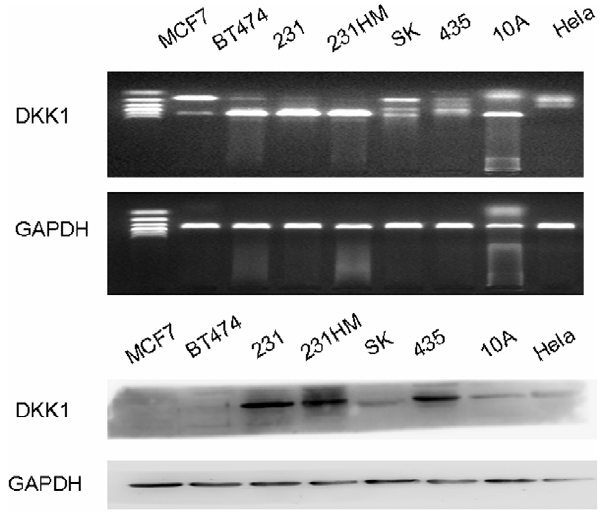
Figure 1. The mRNA and protein expression of DKK1 in breast cancer cell lines. A) The mRNA expression of DKK-1 in MCF-7, BT474, MDA-MB231, MDA-MB231HM, SK, MDA-MB-435, MCF-10A and Hela cells. B) The expression of DKK1 in MCF-7, BT474, MDA-MB231, MDA- MB231HM, SK, MDA-MB-435, MCF-10A and Hela cells by western blot.